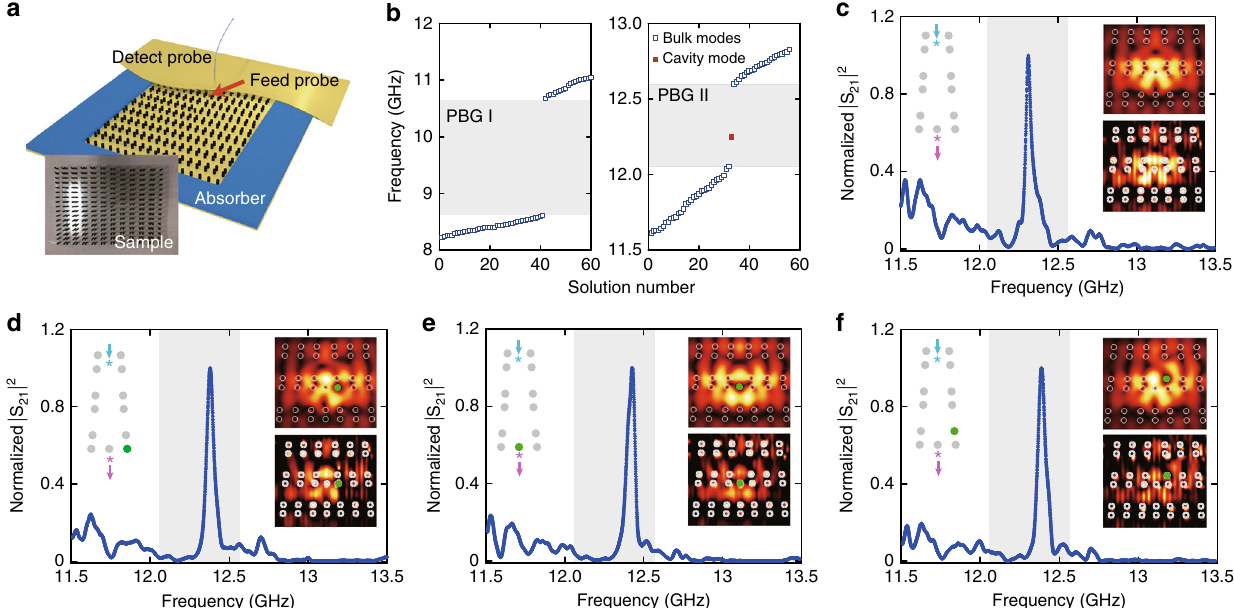
Fig. 5 Robust topological cavity mode on a dislocation. a Experimental setup: the photonic crystal with a dislocation is cladded above and below by aluminum plates and mounted onto a 2D mapping system. b Bulk and cavity modes from simulation for PBG I (left) and PBG II (right). There is only one cavity mode in PBG II, whereas no cavity mode in PBG I. c – f Transmission and fi eld pro fi les (upper insets: simulation, lower insets: experiments). The left insets show the structure near the dislocation: the gray points represent the YIG pillars and the green points denote metallic pillars. The upper arrows indicate electromagnetic wave injection at the cyan asterisk point, while the lower arrows indicate electromagnetic wave detection at the purple asterisk point in transmission